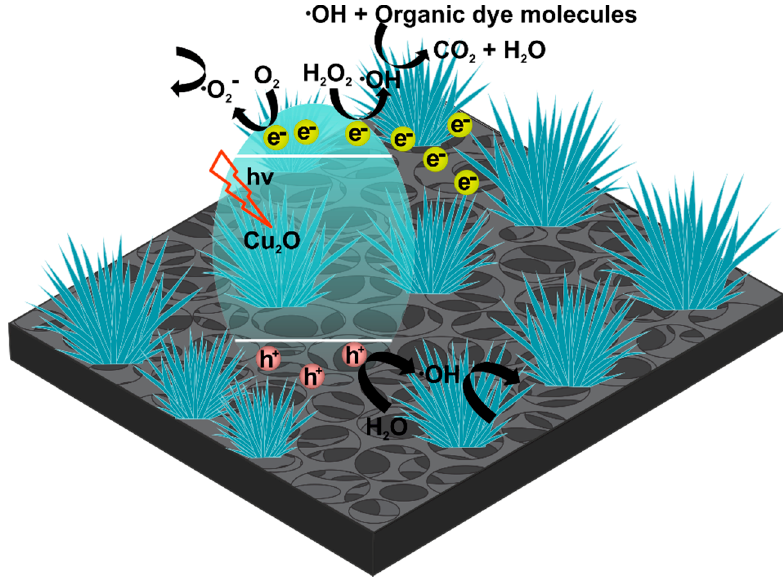
Figure 7. Schematic illustration of the possible mechanism for the RhB degeneration by the Cu 2 O@NPC composite. Figure adapted from [165].